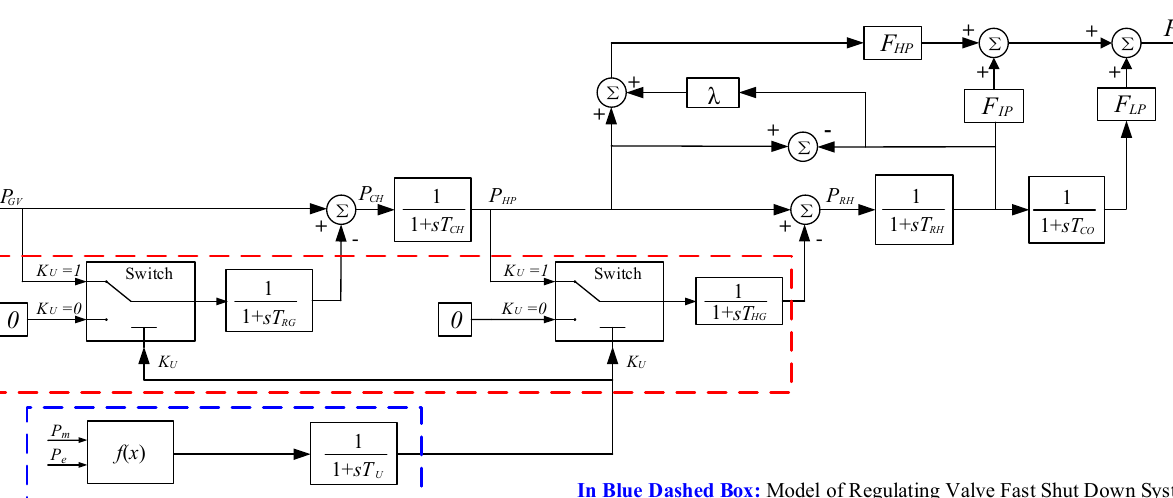
Figure 7. The steam turbine model of the FCB unit.